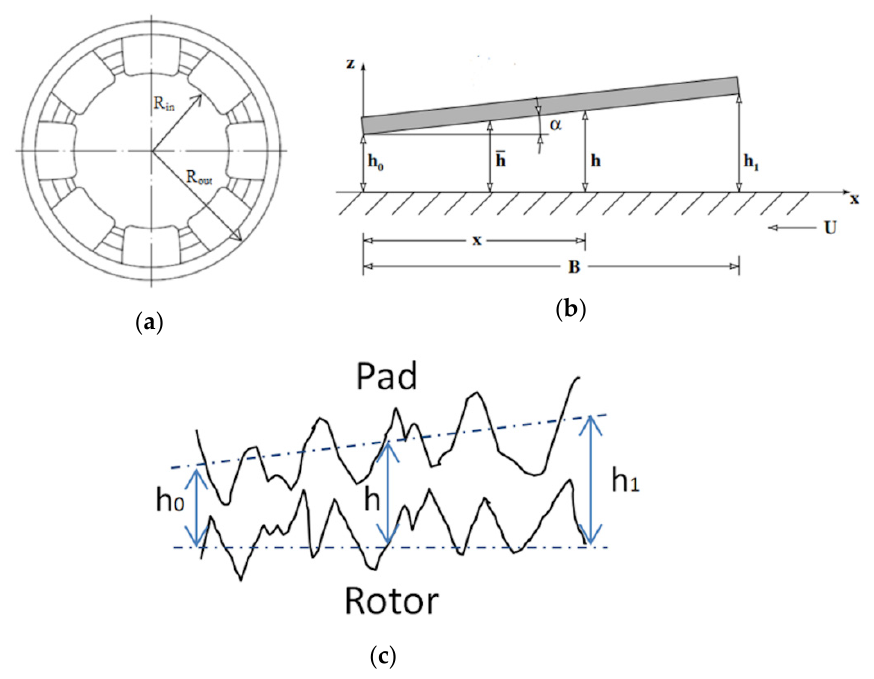
Figure 2. ( a ): Thrust bearing assembly [27]; ( b ): Schematic of the pivoted pad [46]. Reprinted with